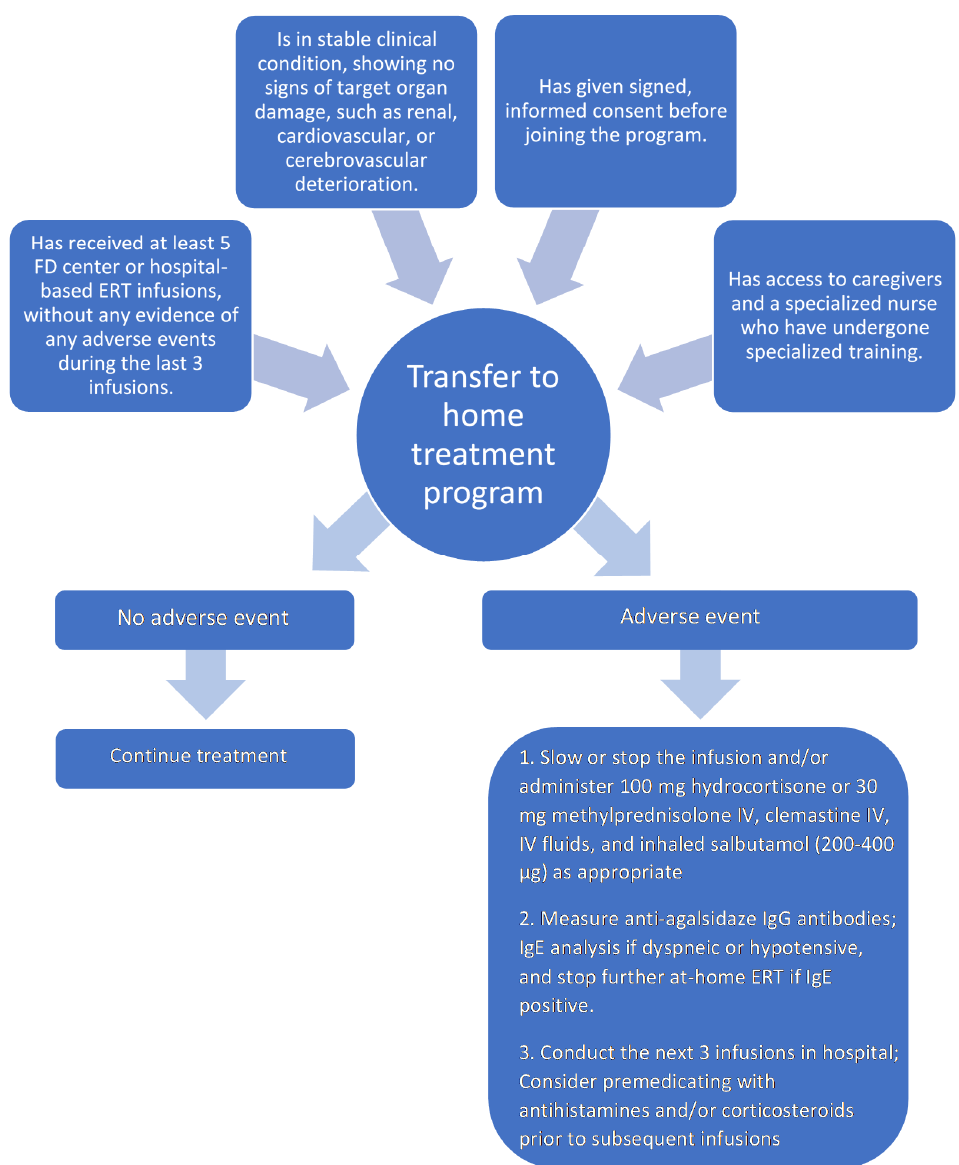
Figure 1. Patient selection process for initiation and continuation of at-home ERT.